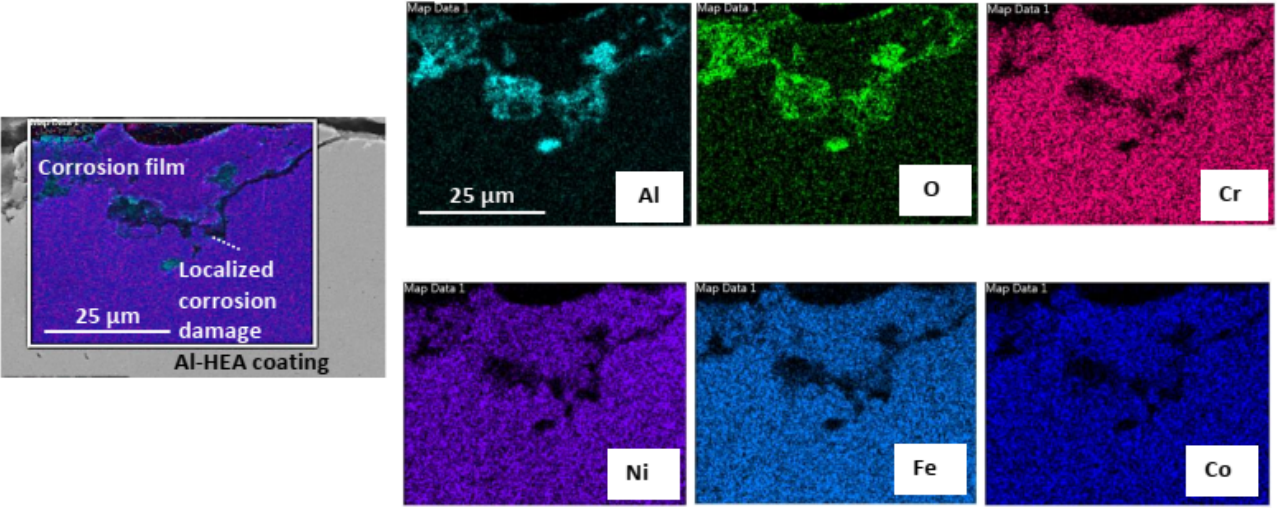
Figure 11. Elemental mapping of localized corrosion damage observed on the surface of exposed AL-HEA coating in the aerated test.